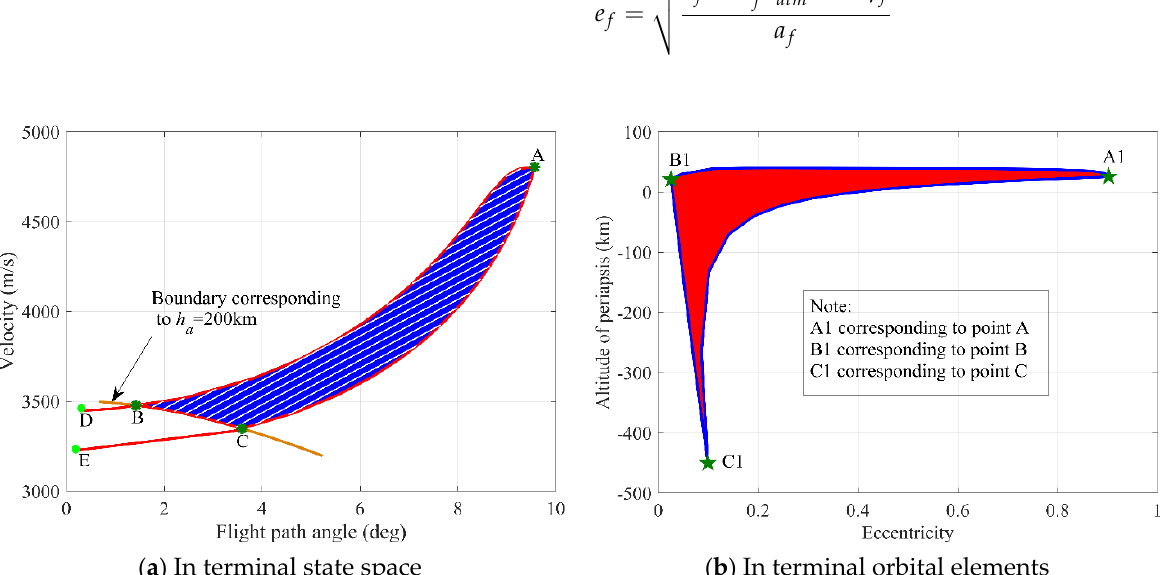
Figure 7. Aerocapture attainability set for the initial state given in Table 1. The nondimensional semimajor axis is a f = 1/ ( 2/ r atm − V 2 terminal orbit has a nondimensional altitude h p , f = a f ( 1 − e f ) − 1. As shown in the